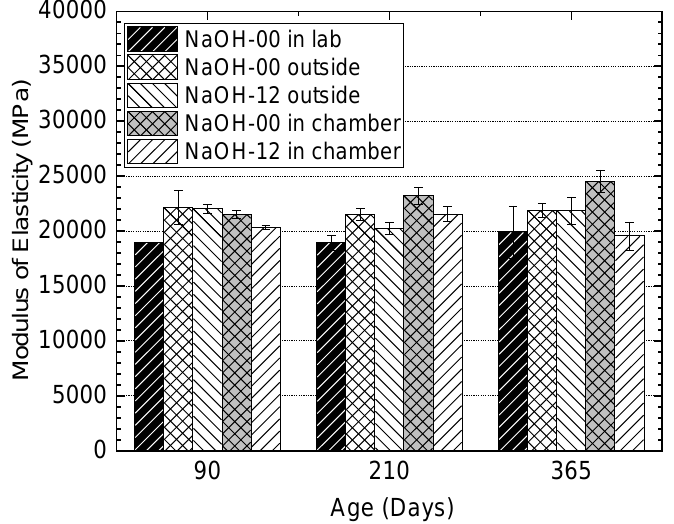
Figure 17. Effect of alkali addition on the elastic modulus of concrete at different ages.